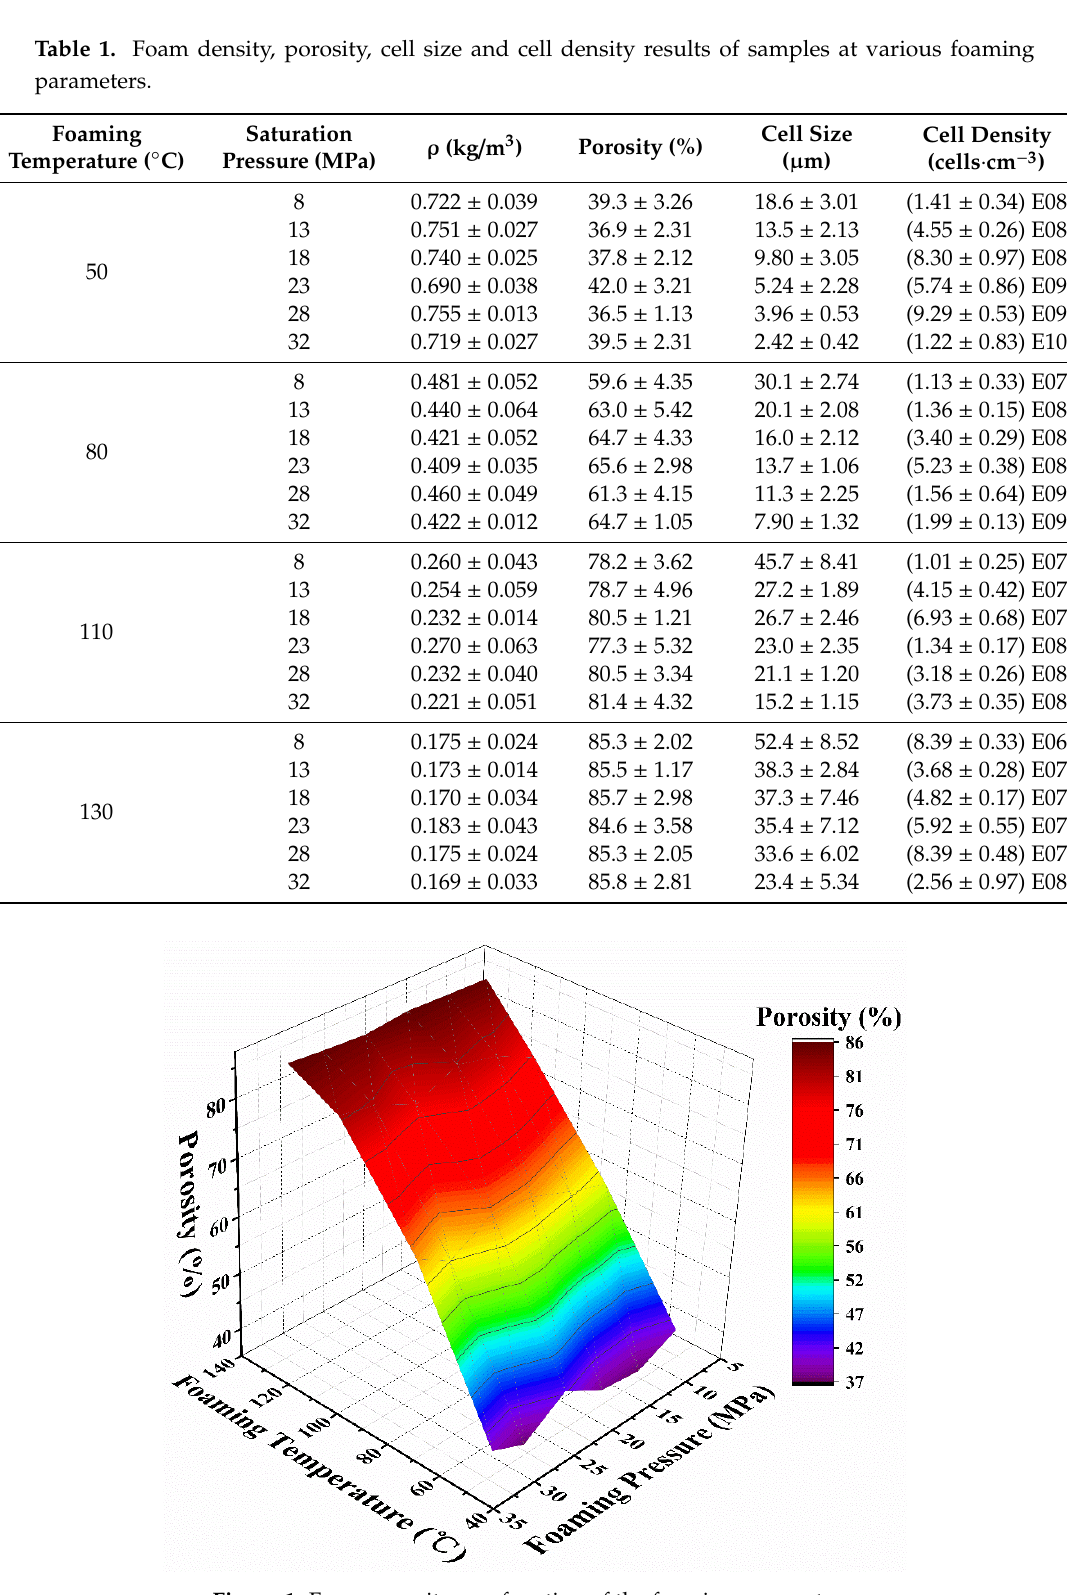
Figure 1. Foam porosity as a function of the foaming parameters.